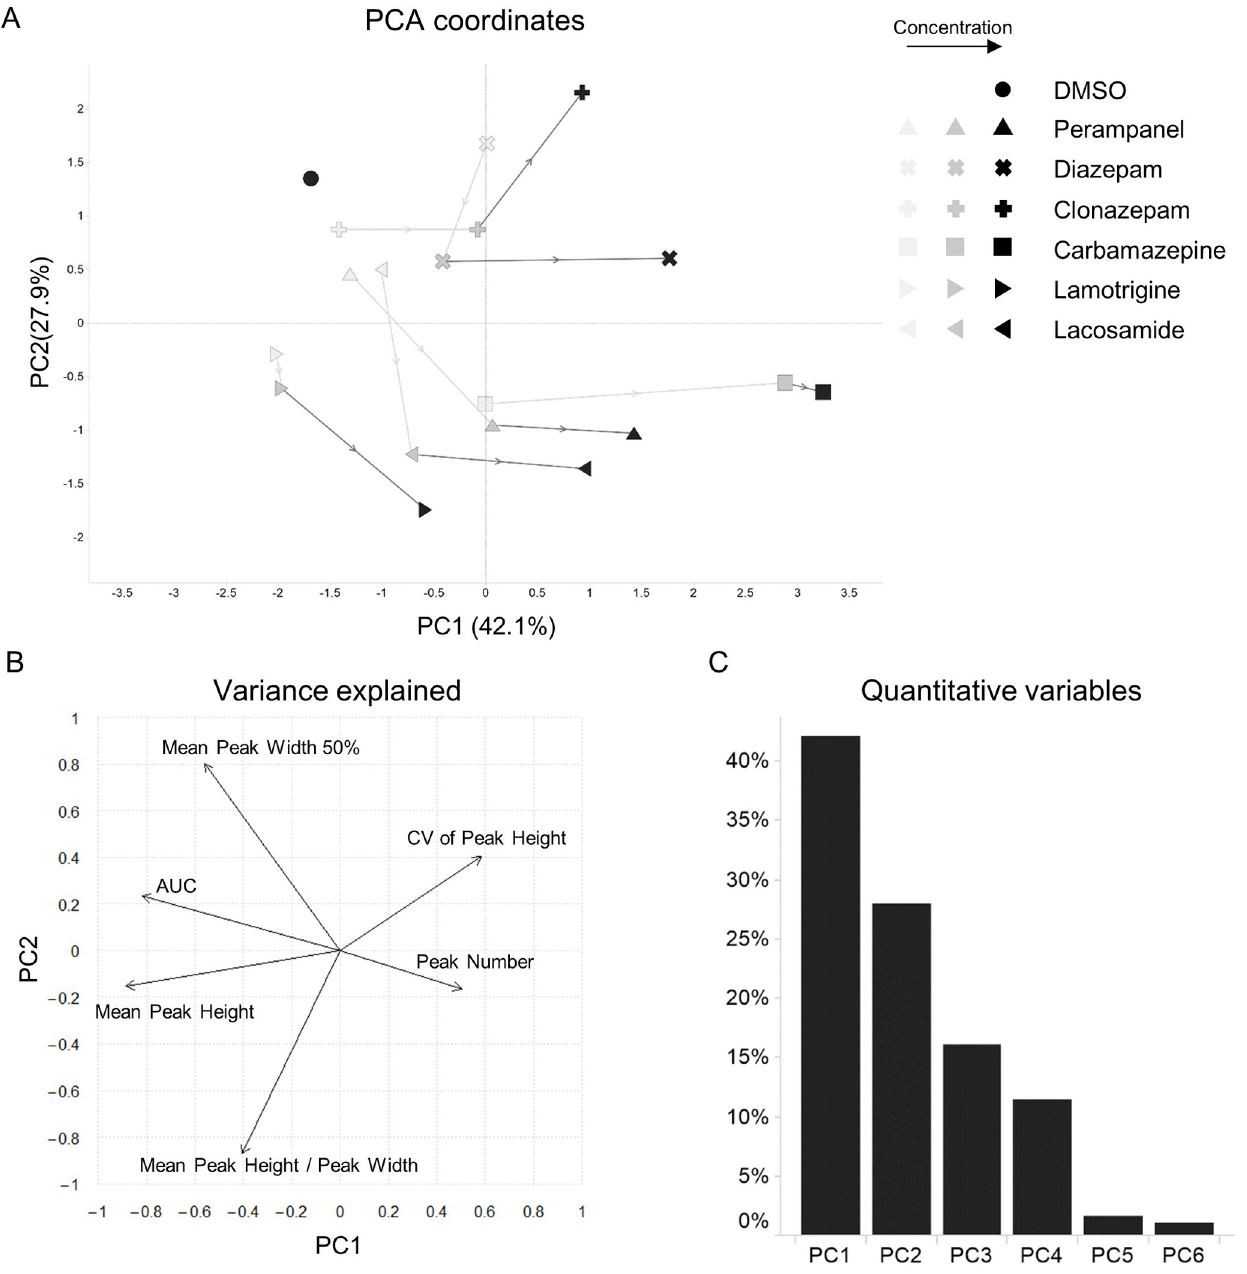
Fig 5. Trajectories of PCA plots in accordance with concentrations of AEDs. (A) PCA of wave features. The centers of wells are depicted under the same conditions. Different AEDs display different shapes. Light colors depict low concentrations, whereas dark colors represent high concentrations. Plots of the same AEDs are connected by lines in order of the concentration used. (B) Plot depicting the contribution of features to PC1 and PC2 (arrows). (C) Bar plots displaying the specific proportion of total variance explained by each PC.